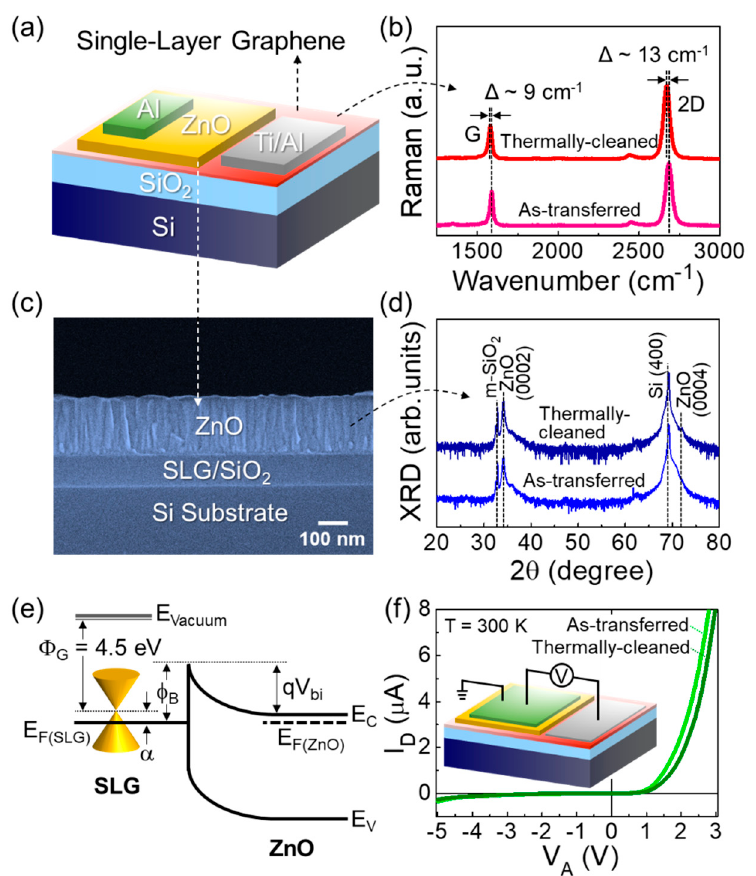
Figure 2. ( a ) Schematic of the ZnO / SLG Schottky PD. ( b ) Raman spectra of the as-transferred and the thermally-cleaned SLG sheets. ( c ) Cross-sectional view of the SEM image for the ZnO layer grown on the SLG / SiO 2 / Si substrate. ( d ) XRD patterns of the ZnO layers grown on the as-transferred and the thermally-cleaned SLG sheets. ( e ) Expected energy band diagram of the ZnO / SLG Schottky PD at thermal equilibrium. ( f ) I–V characteristics of the ZnO / AT-SLG and the ZnO / TC-SLG Schottky PDs. The inset of (f) shows the schematic configuration of the bias setup for the electrical characterization of the fabricated device.